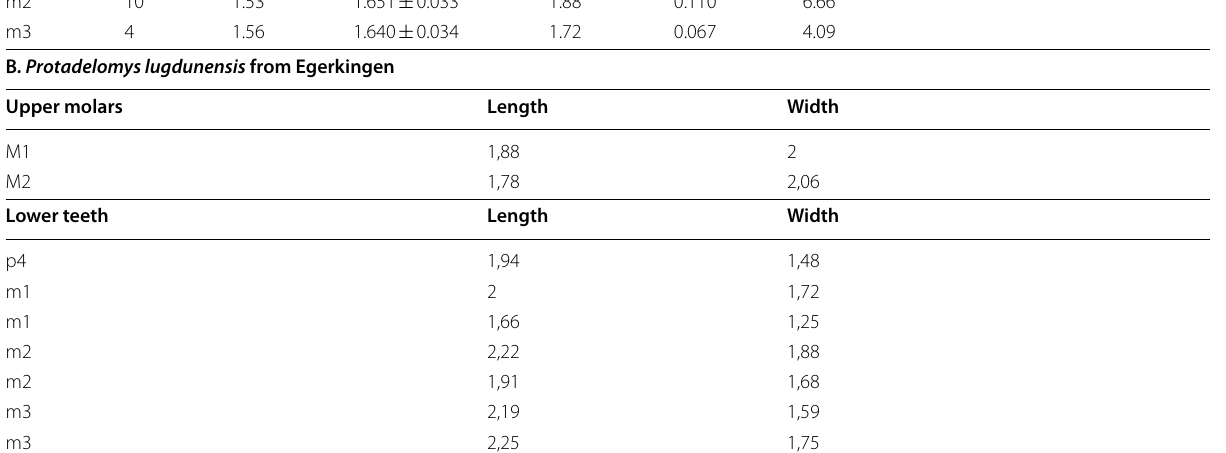
Table 1 Range of the size variations (length and width: min., max.; average different loci of teeth of Protadelomys cartieri Hartenberger, 1969 and B. length and width for some loci only Protadelomys lugdunensis Hartenberger, 1969 from Egerkingen (MP 14; Swiss Jura). For A: equations (Y) of the regression lines and correlation rates (R 2 ) between length and width of the different loci of teeth A Protadelomys cartieri from Egerkingen